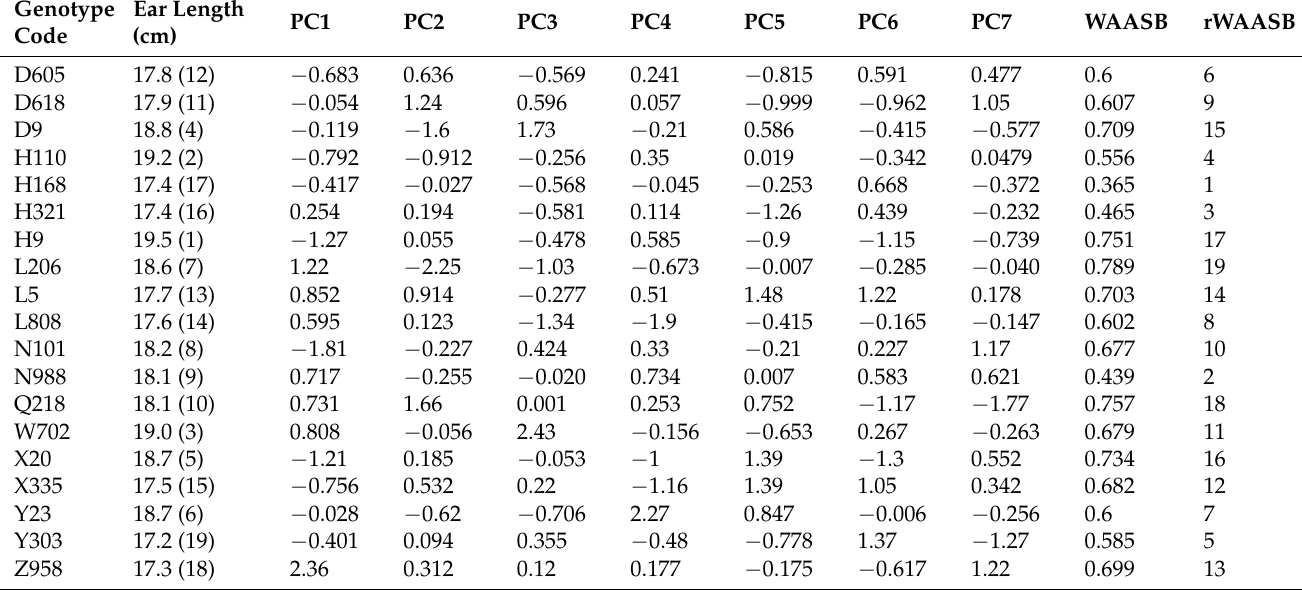
Table 5. The mean ear length and WAASB scores of evaluated genotypes.